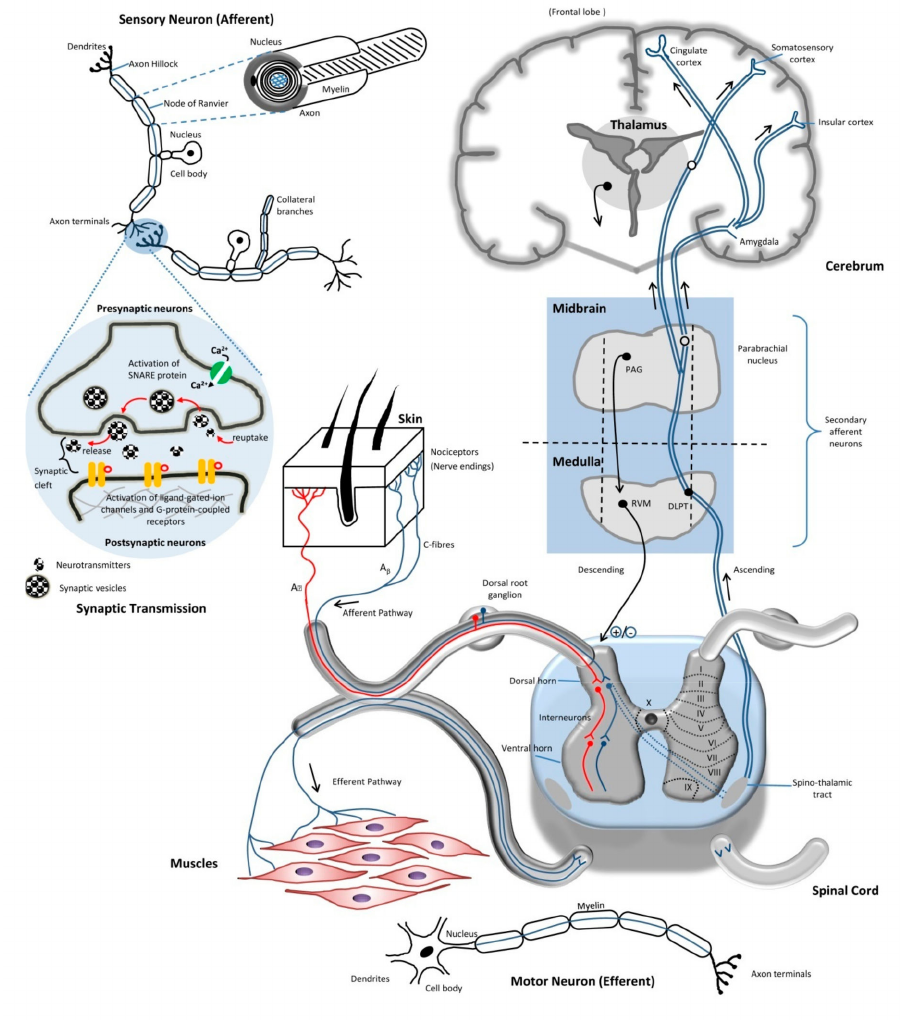
Figure 1. The basic route of pain transmission upon noxious stimuli in ascending and descending order, and the illustration of synaptic transmission in synaptic